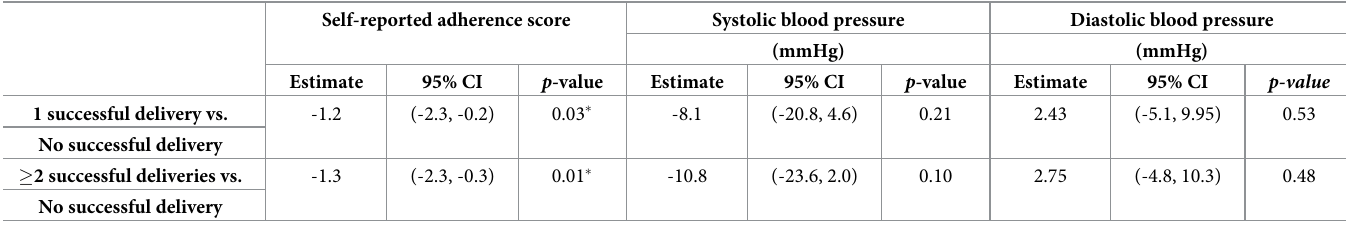
Table 3. Mixed-effect model